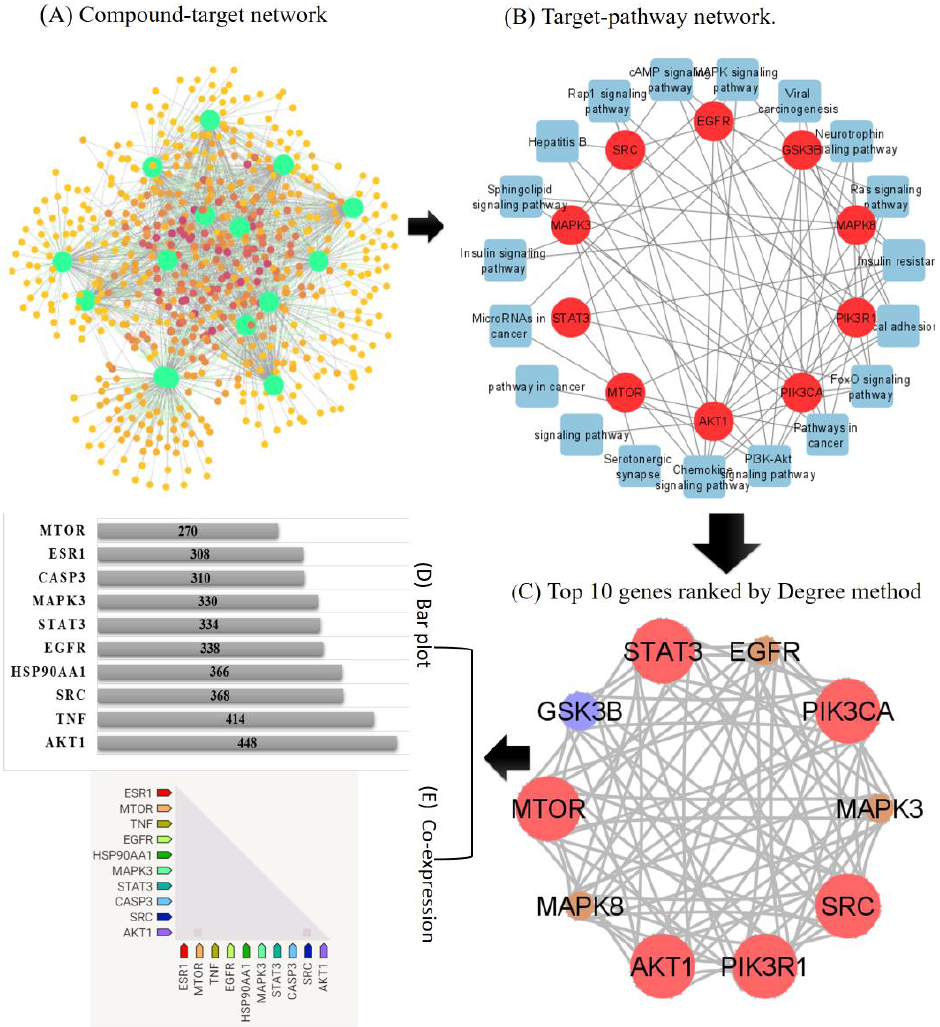
Figure 1. Network pharmacology-based analysis of multi-compound, multi-target, and multi-pathway treatment for liver cancer. ( A ) Network diagram of compounds and their targets. Size and color of gene and compound ’s nodes represent their degree ( B ) Network diagram of target genes – enrichment pathways. The blue square indicates the pathways and pink nodes indicates the target. ( C ) Top 10 genes ranked by degree method. ( D ) The bar plot of the PPI network. ( E ) Observed expression of 10 target genes in Homo sapiens .